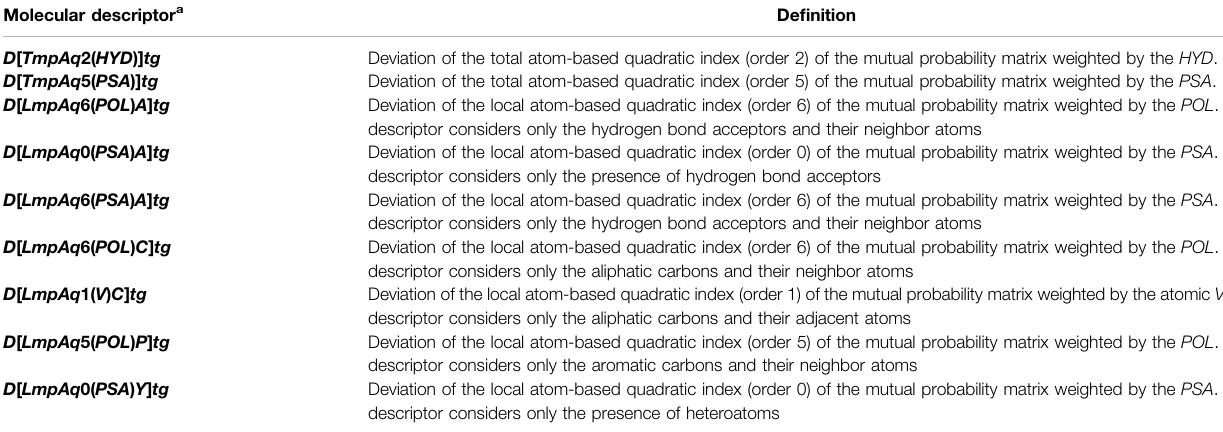
TABLE 1 | Molecular descriptors and their de fi nitions. Molecular descriptor a De fi nition